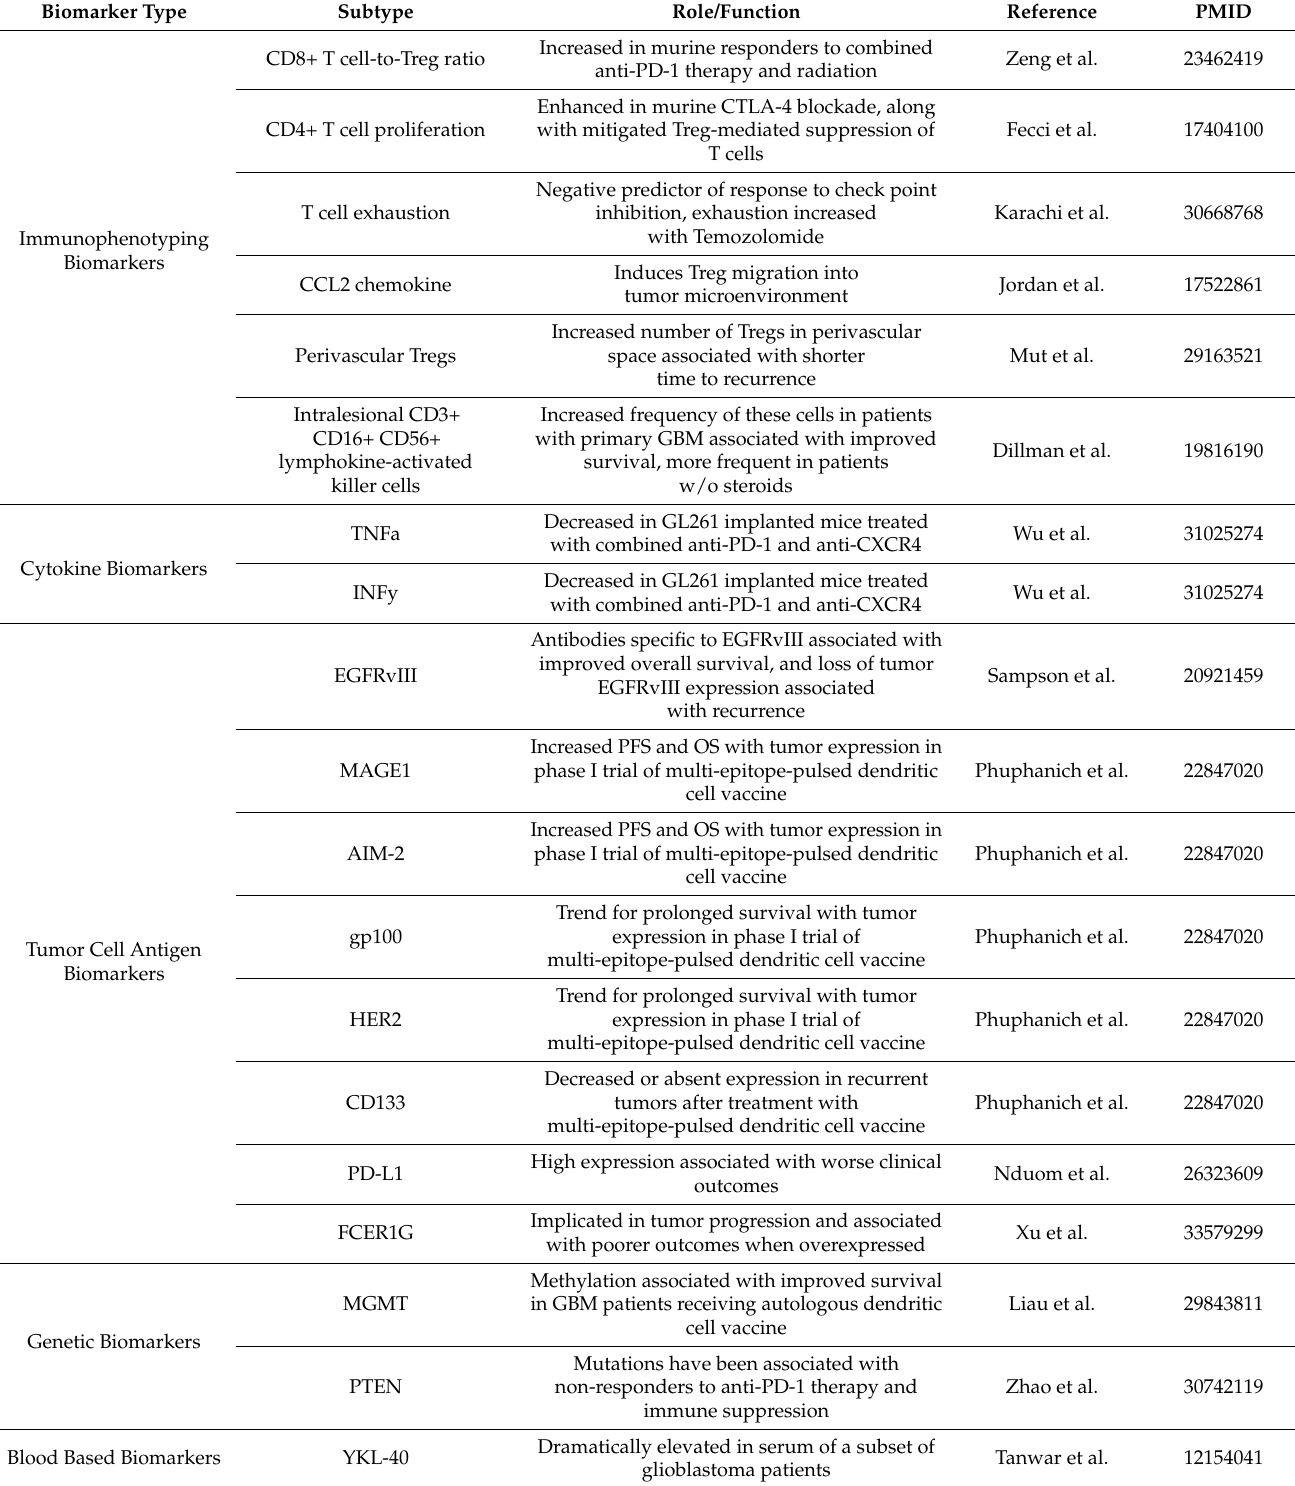
Table 1. Biomarkers for glioblastoma